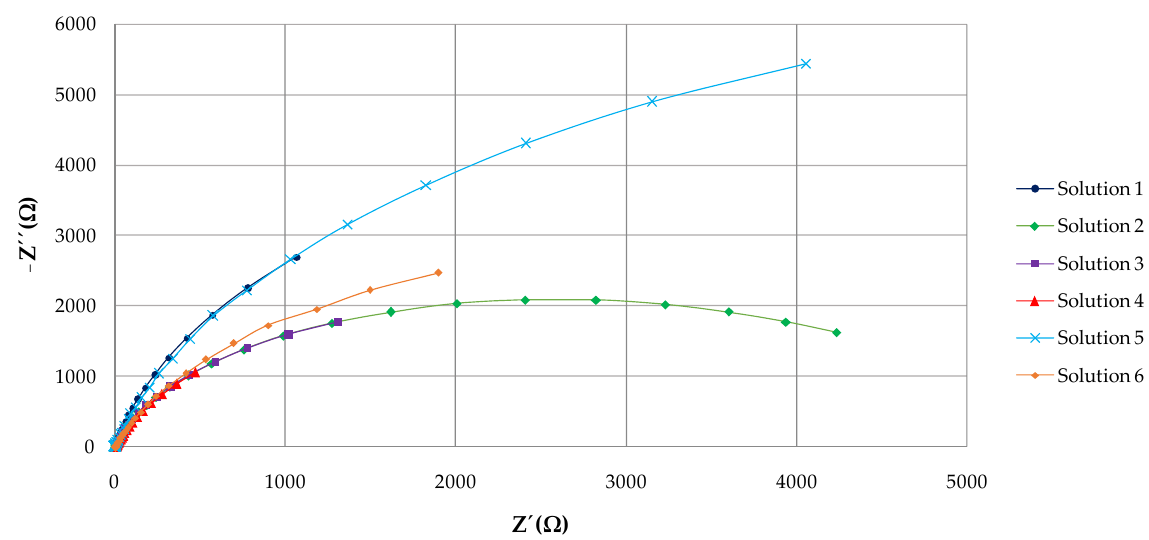
Table 3. Parameters obtained through Equivalent Circuit of the Nyquist Diagram.